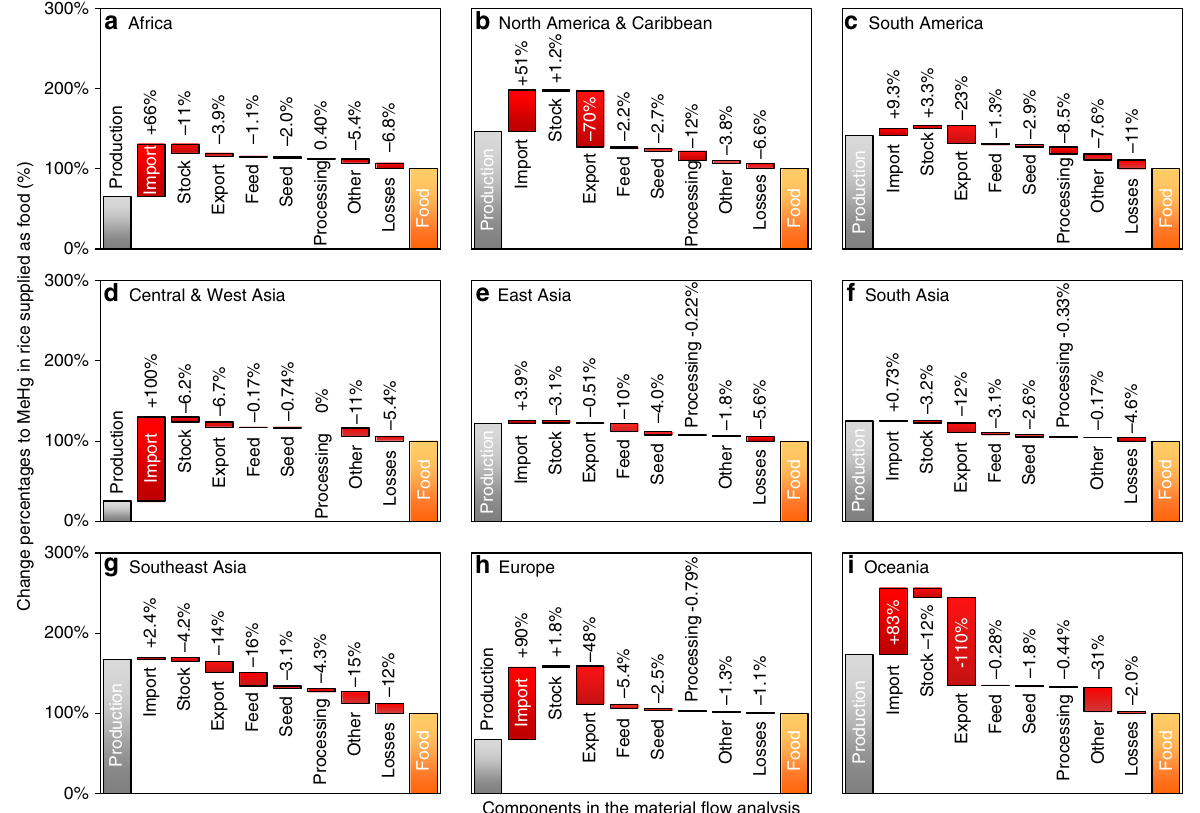
Fig. 4 Life cycle of methylmercury generated in rice grain. Components of the life cycle of MeHg generated in rice grain include rice production, import, export, stock variation, and domestic supplies (including food, feed, seed, processing, losses, and other uses). a – i represent different regions, i.e., Africa ( a ), North America & Caribbean ( b ), South America ( c ), Central & West Asia ( d ), East Asia ( e ), South Asia ( f ), Southeast Asia ( g ), Europe ( h ), and Oceania ( i ) in the world. The life cycle of THg generated in rice grain in different regions are included in Supplementary Data 1. Data are in